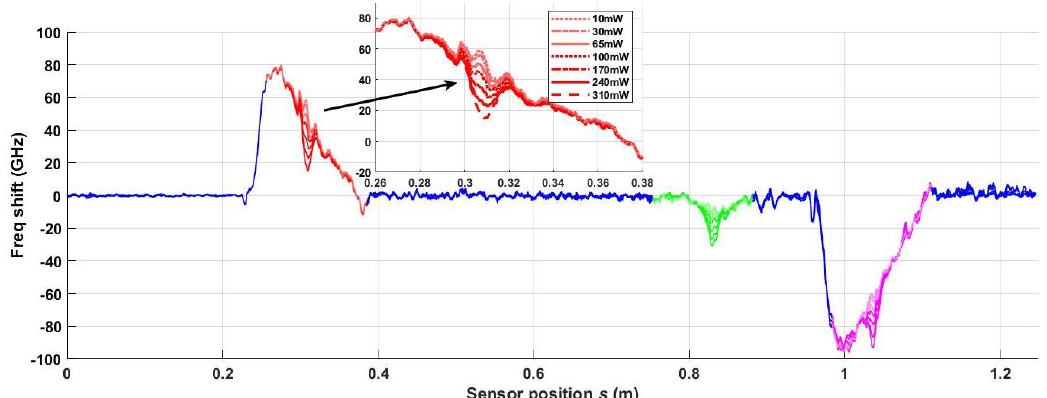
Figure 11. Time-averaged frequency shifts resulting from both strain and the incidence of laser energy at seven optical power levels.